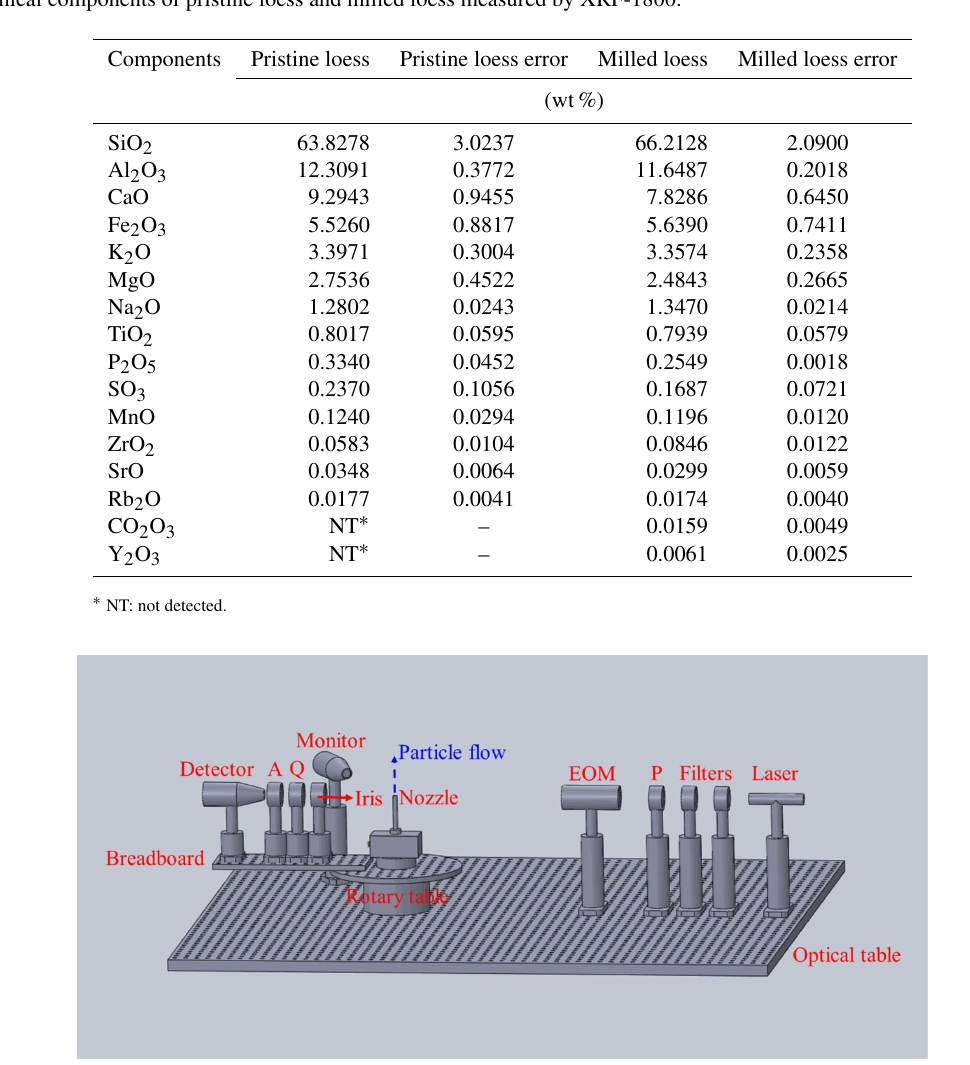
Figure 3. Layout diagram of the experimental apparatus after backscattering angle